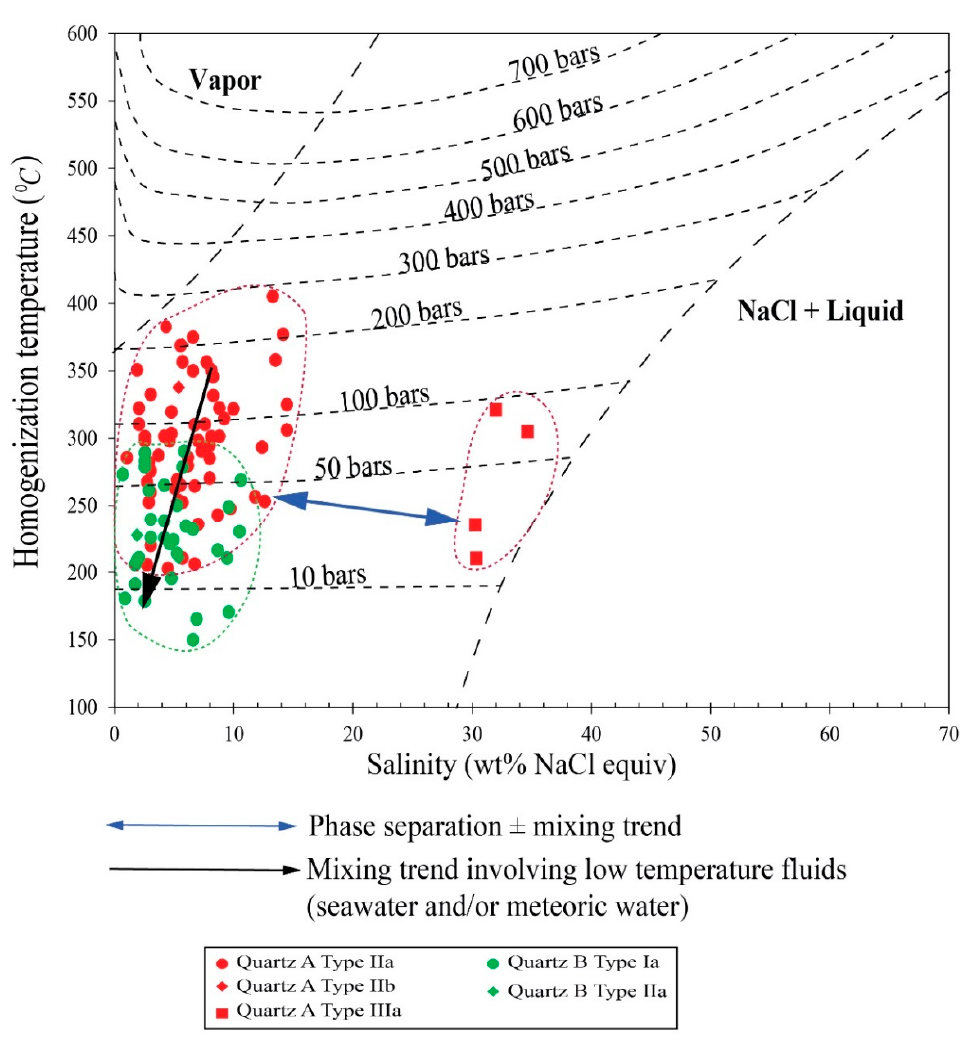
Figure 14. ( a ) Relationship between homogenization temperatures of CO 2 –Th(CO 2 ) and amount of CO 2 fraction–X(CO 2 ) for Type IIIb aqueous-carbonic fluid inclusions. ( b ) The P–T diagram of isochores plotted for Type IIIb aqueous-carbonic fluid inclusions of ρ min and ρ max intersected by isopleth of 7 mol% CO 2 .